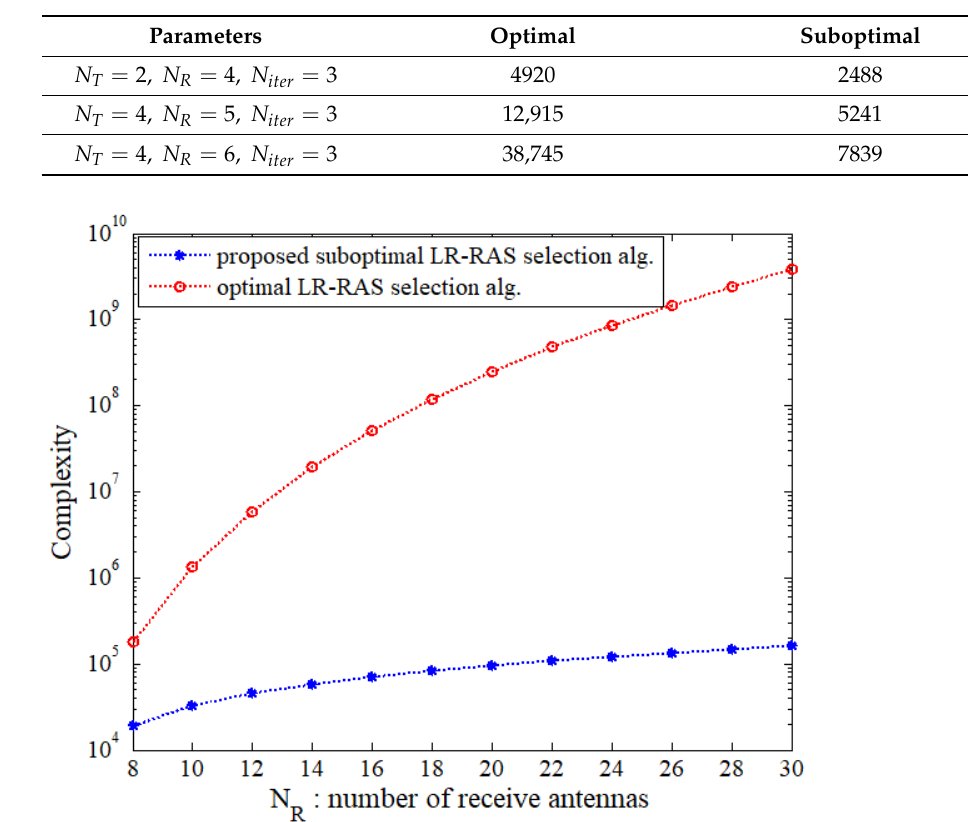
Figure 5. Complexity comparison of the proposed algorithm and optimal one for N T = 6 and N iter = 3 .